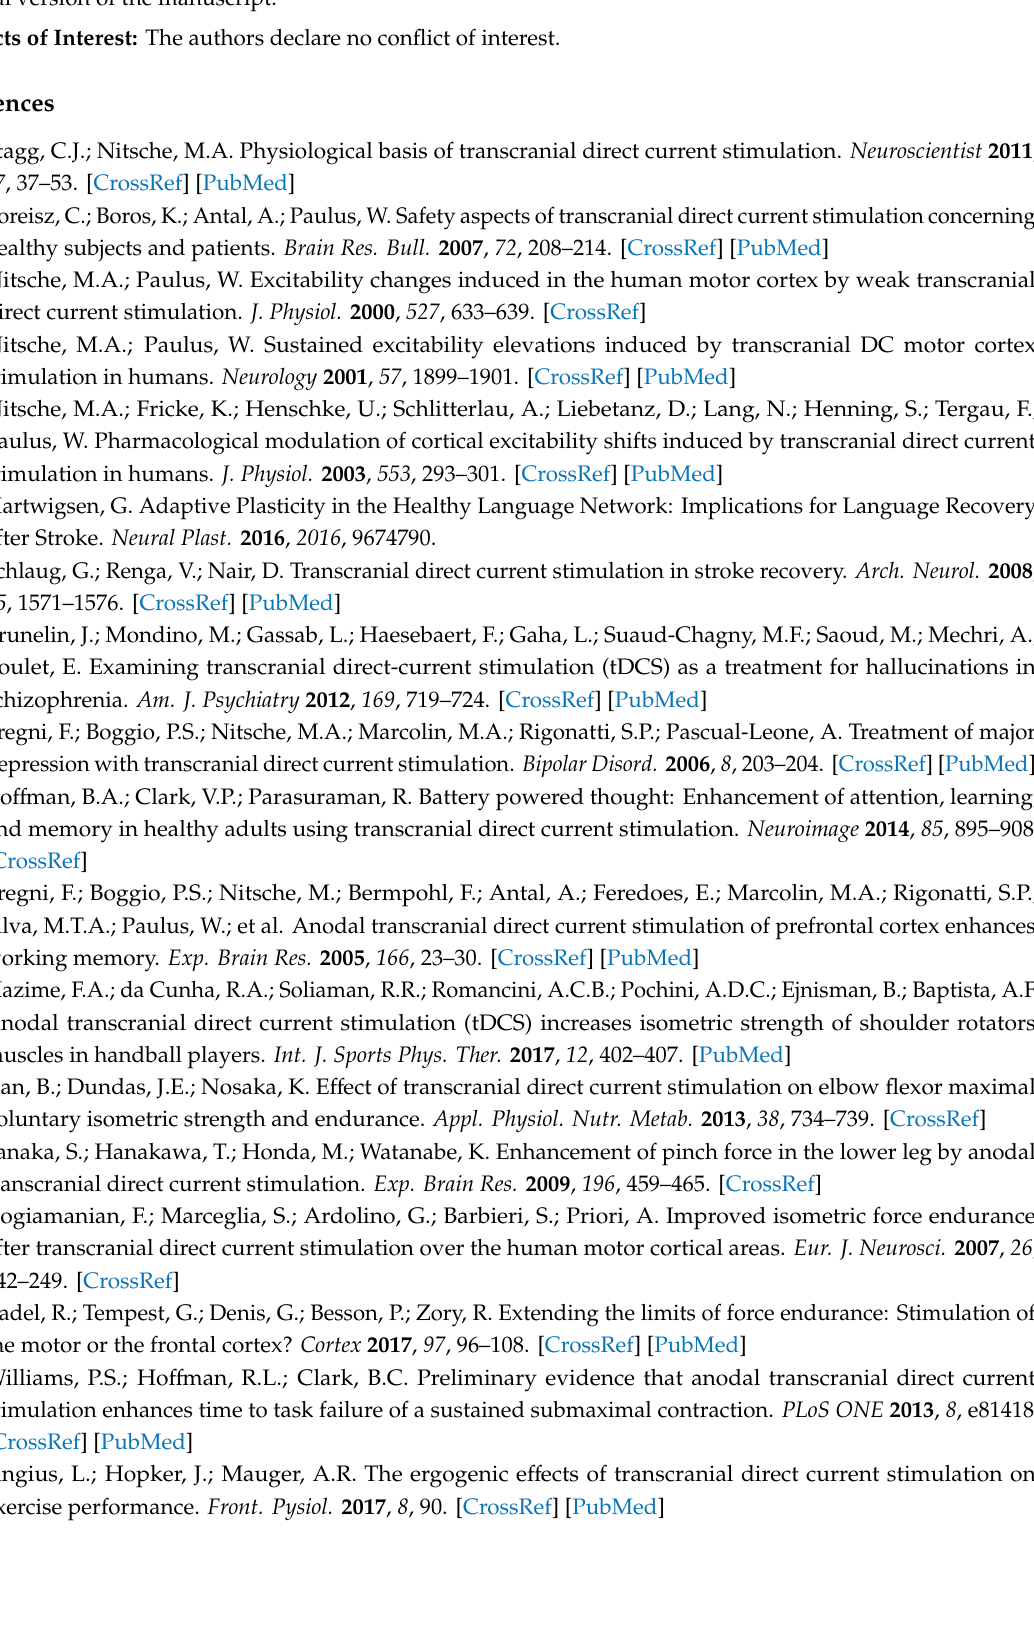
Figure S1: Funnel plot for MVC (A) and TTF (B) studies; Table S1: PEDro ratings of the qualitative